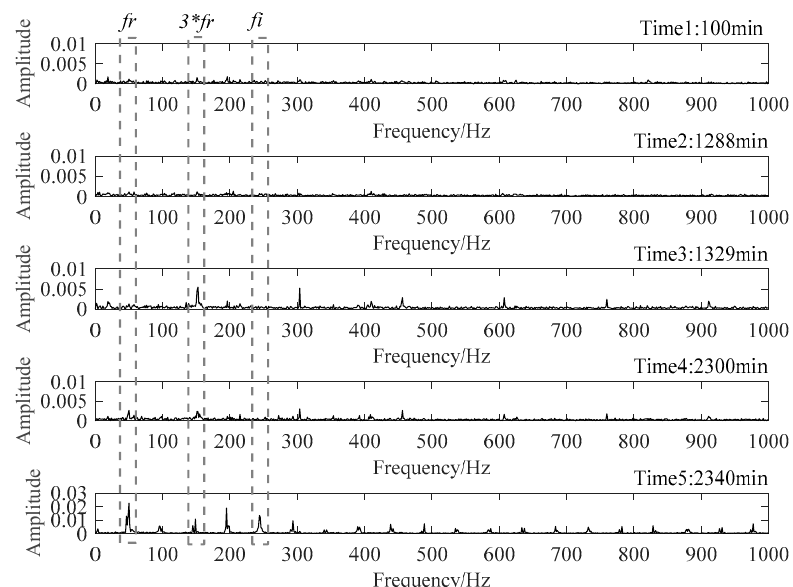
Figure 11. Envelop spectra of five representative moments.